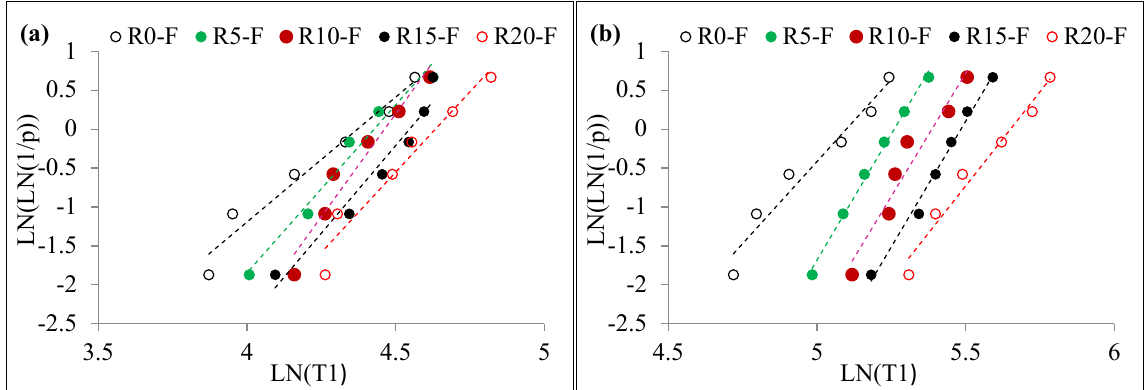
Figure 11. Weibull lines for non-fibrous specimens ( a ) T1 and ( b ) T2.